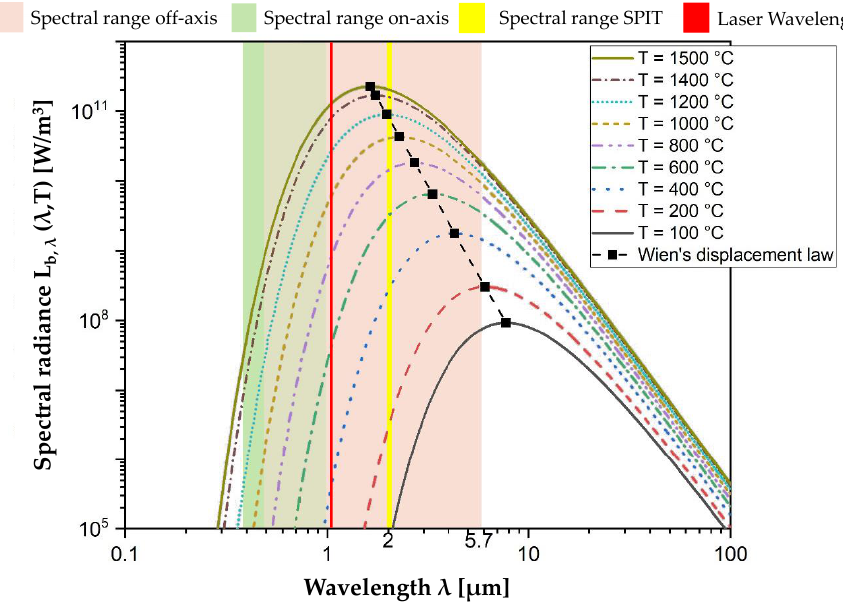
Figure 3. Visual representation of the spectral radiance distribution of a black body (Planck spectrum) and Wien’s displacement law for temperatures between 100 °C and 1500 °C [20]. The common spectral range of on-axis (light green area) and off-axis (light red area) systems, as well as the spectral range of the SPIT system (yellow bar) and the laser wavelength (red bar) are highlighted. The melting range of the material used in this investigation (AlMg3) is between 595 °C and 645°C [30].